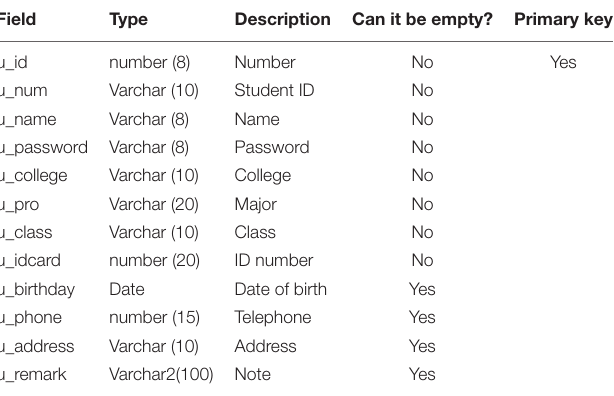
FIGURE 3 | Exchange interaction timing diagram.